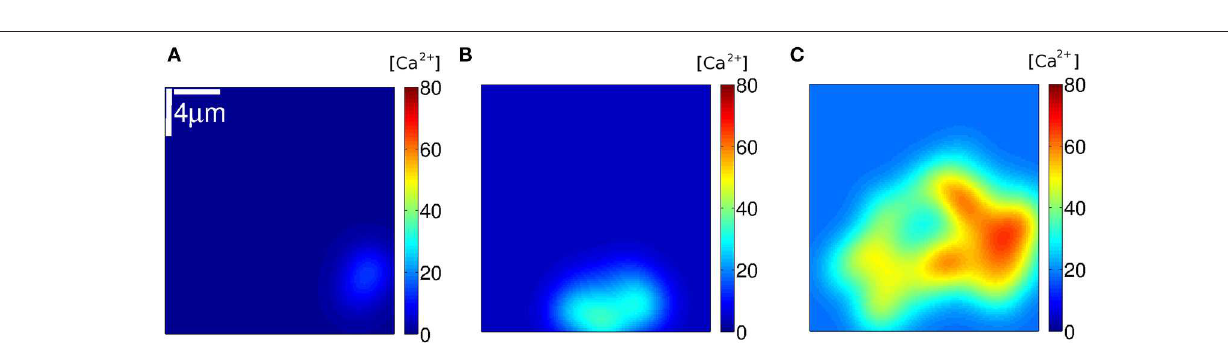
FIGURE 8 | [Ca 2 + ] distribution of events in three instants (A–C) of stochastic simulations with a mean separation between clusters of 4 µ m and δ Ca (condition S1 ). Example (A) corresponds to N o